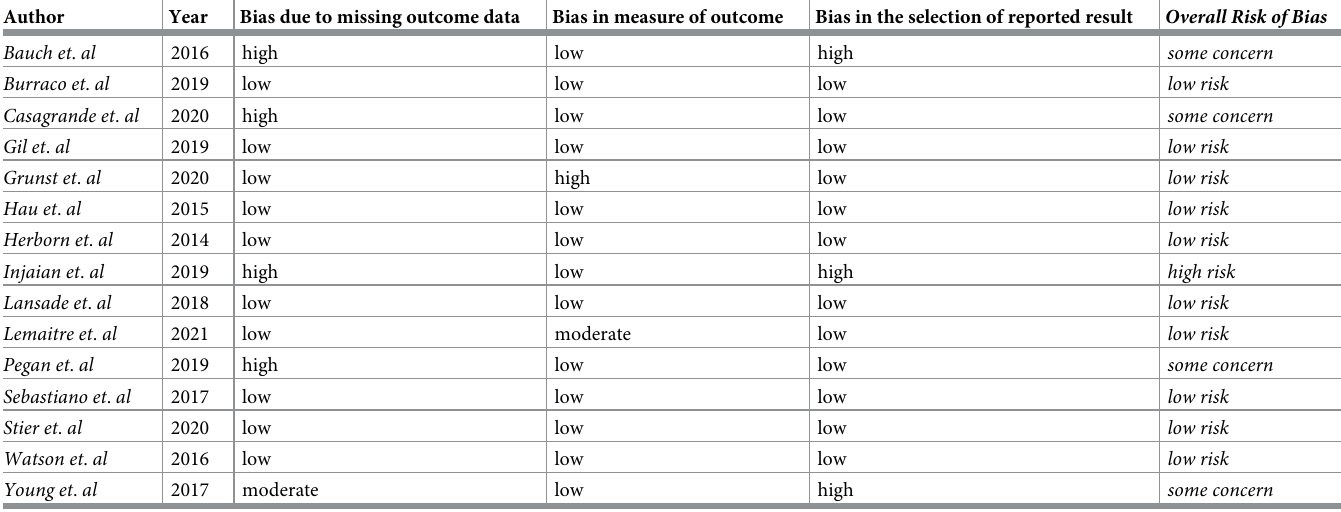
Table 2. Overall risk of bias assessed based on missing outcome data, measure of outcome and in the selection of reported